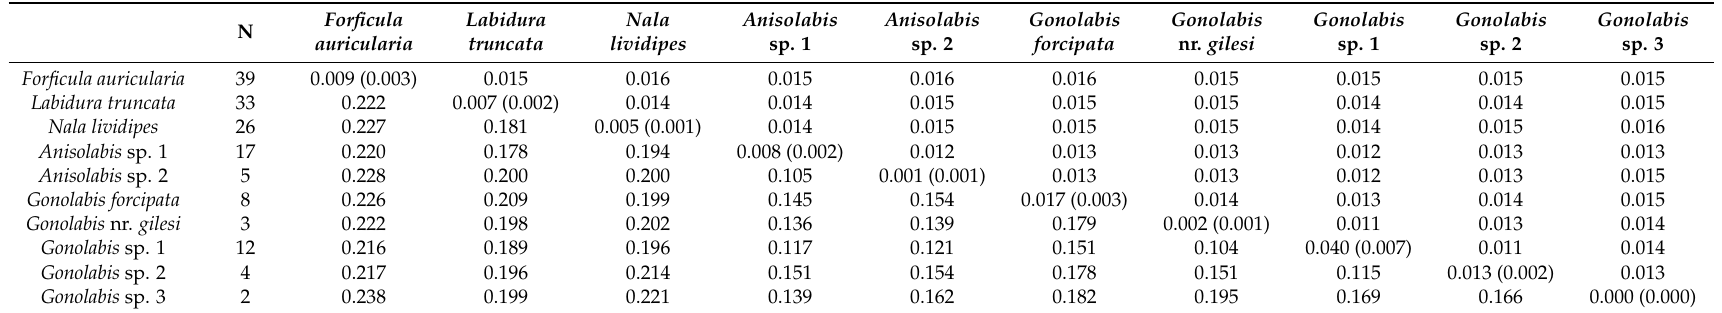
Table 2. Uncorrected p-distances within and between Dermaptera morphospecies cytochrome c oxidase subunit 1 barcodes (658 bp). Interspecific means and variances are shown on the left and right of the diagonal. Intraspecific mean shown on diagonal with variance in brackets. Variances were calculated using 1000 bootstraps. N refers to number of individuals of morphospecies sequenced. Comparisons between morphospecies in the Anisolabididae family are delineated by a hashed line. Forficula auricularia refers to clade B from Wirth et al. [58], as clade A is not found in Australia [59].